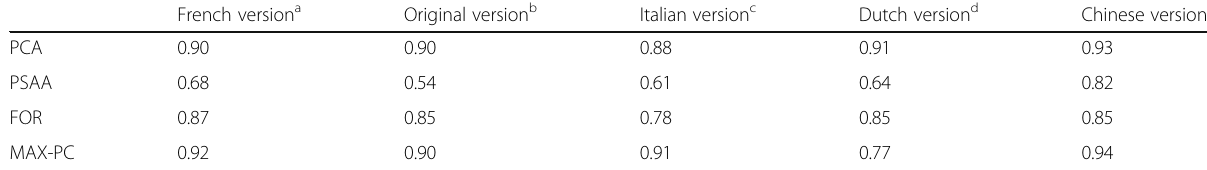
Table 4 Cronbach ’ s alpha coefficients for the French version of the MAX-PC and for other published versions